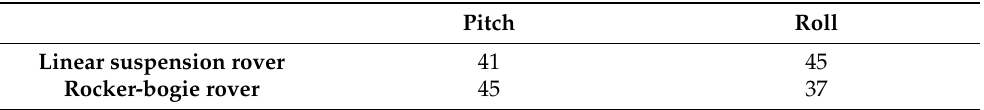
Table 2. Rollover study results for maximum pitch and roll angles 1 .